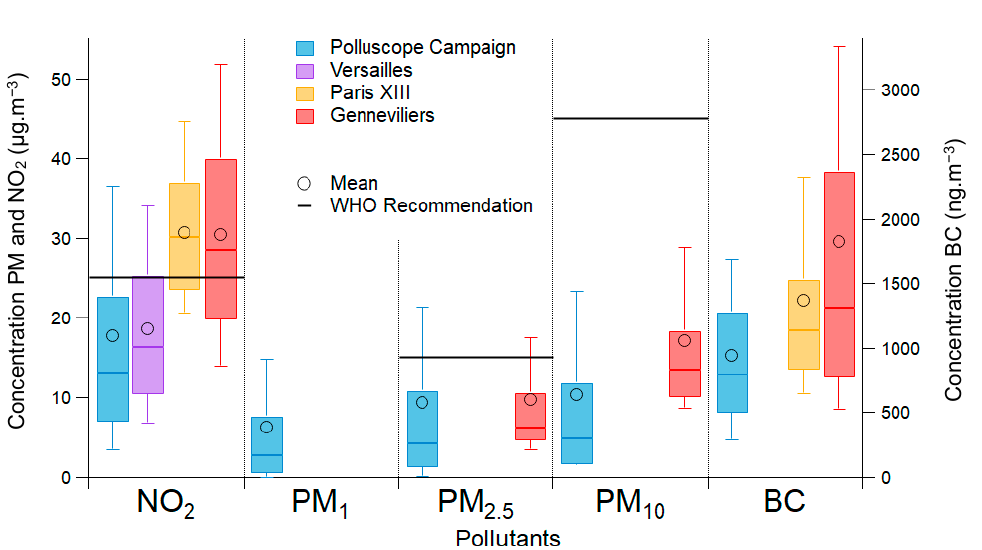
Figure 3. Boxplot of the concentrations measured during the Polluscope campaign and measurements made by the fixed stations of Airparif (Gennevilliers, Paris XIII, Versailles), all data were used with the daily average. The whiskers extend from p10 to p90, the box from p25 to p75, and the median is plotted by the middle line. The black circle represents the mean. The WHO recommendation value is also